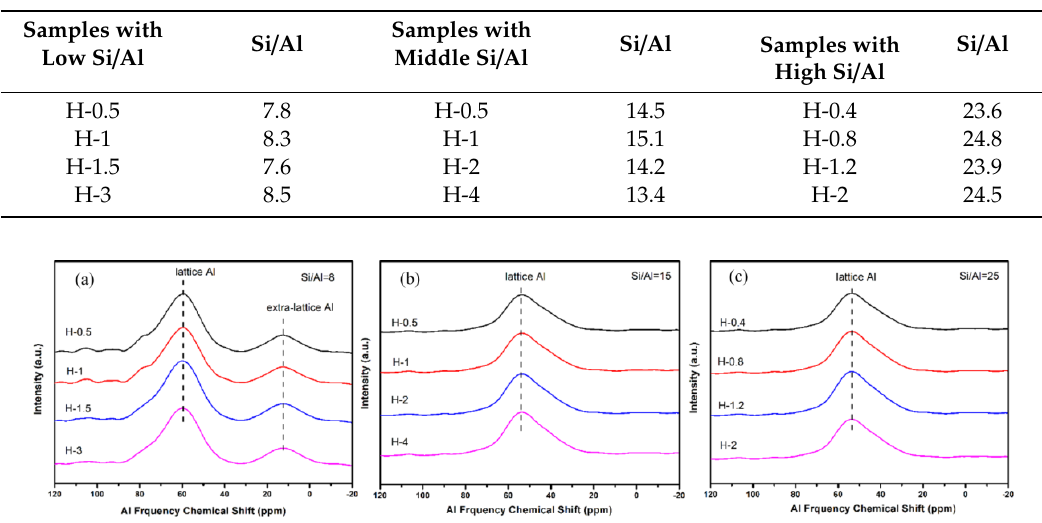
Figure 14. 27 Al NMR results of SSZ-13 with different sizes at different Si/Al ratios. (a) Si/Al=8; (b) Si/Al=15; (c) Si/Al=25.